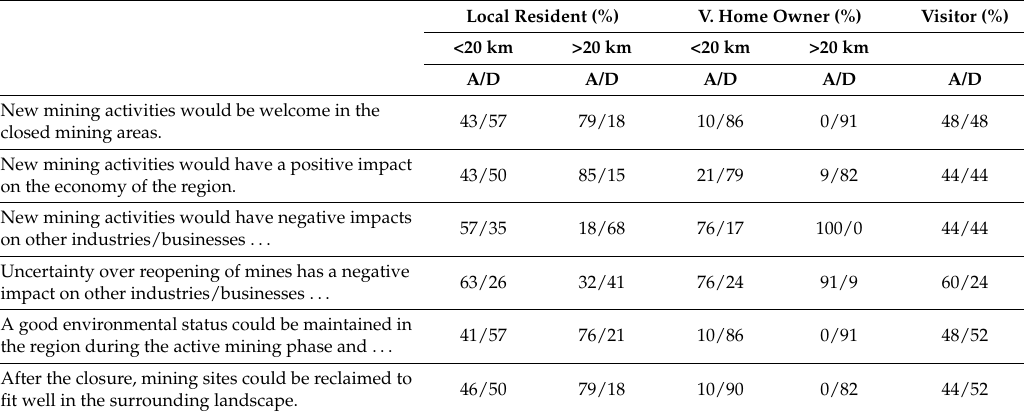
Table 5. Respondents’ opinions on statements related to new mining activities in the Hannukainen/ Rautuvaara region in different stakeholder groups. Proportions for agreement (A) and disagreement (D) are calculated using the total number of respondents within each category: local residents <20 km distance (n = 46) and >20 km distance (n = 34), vacation home owners <20 km distance (n = 29) and >20 km distance (n = 11), and visitors (n =